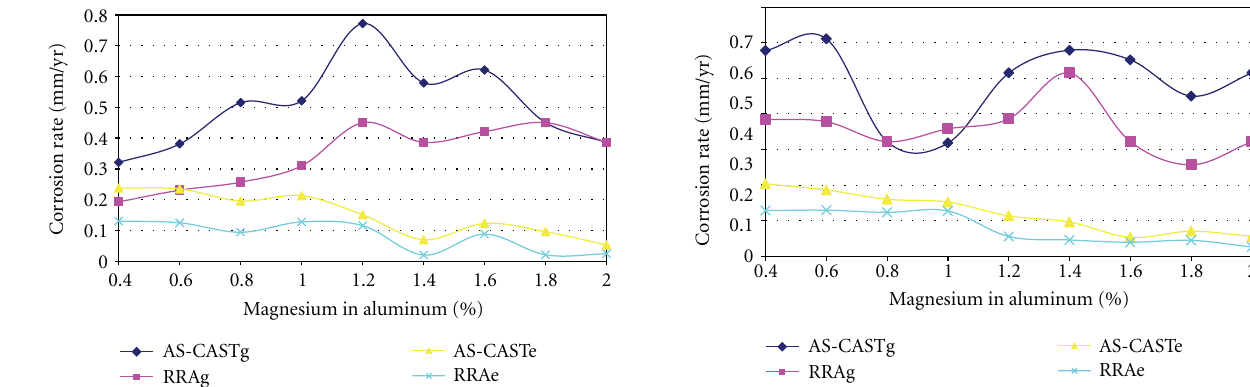
Figure 4: E ff ect of magnesium addition on the corrosion resistance of aluminum alloy in FeCl 3 solution. Note : RRAg and AS-CASTg curves indicate the corrosion responses of heat-treated and as- cast Al-Mg alloy specimens, respectively, in ferric chloride solution as evaluated through the gravimetric technique while RRAe and AS-CASTe curves illustrate the corrosion behaviors of heat-treated and as-cast Al-Mg alloy specimens, respectively, in ferric chloride solution as evaluated through the electrochemical polarization technique.